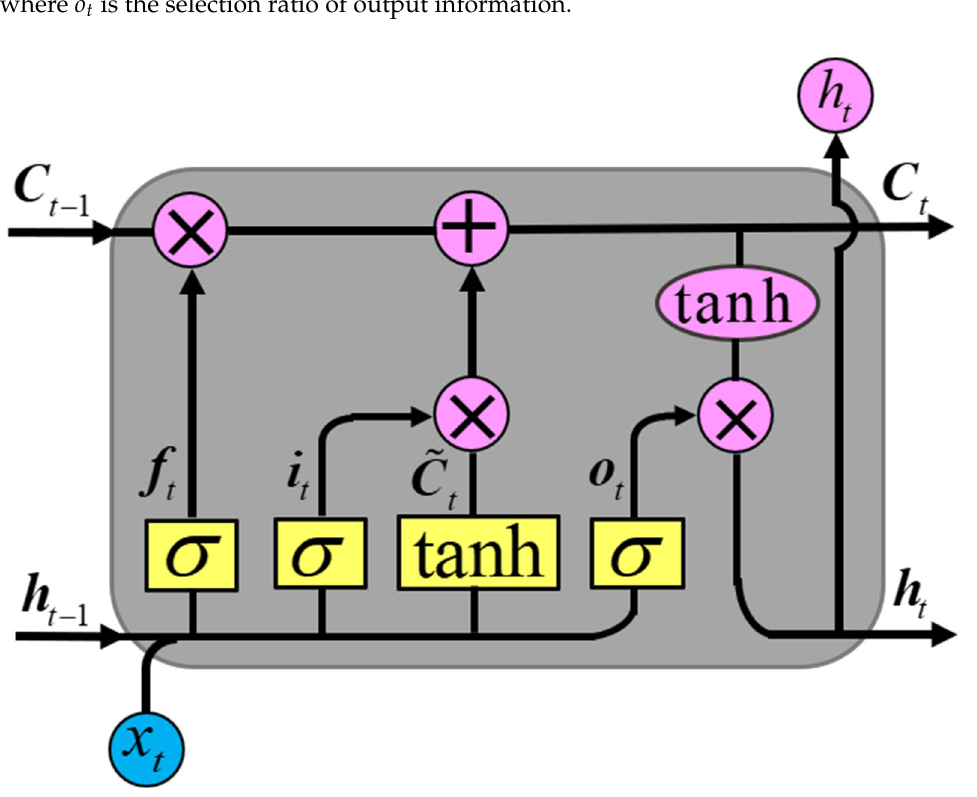
Figure 3. LSTM unit.